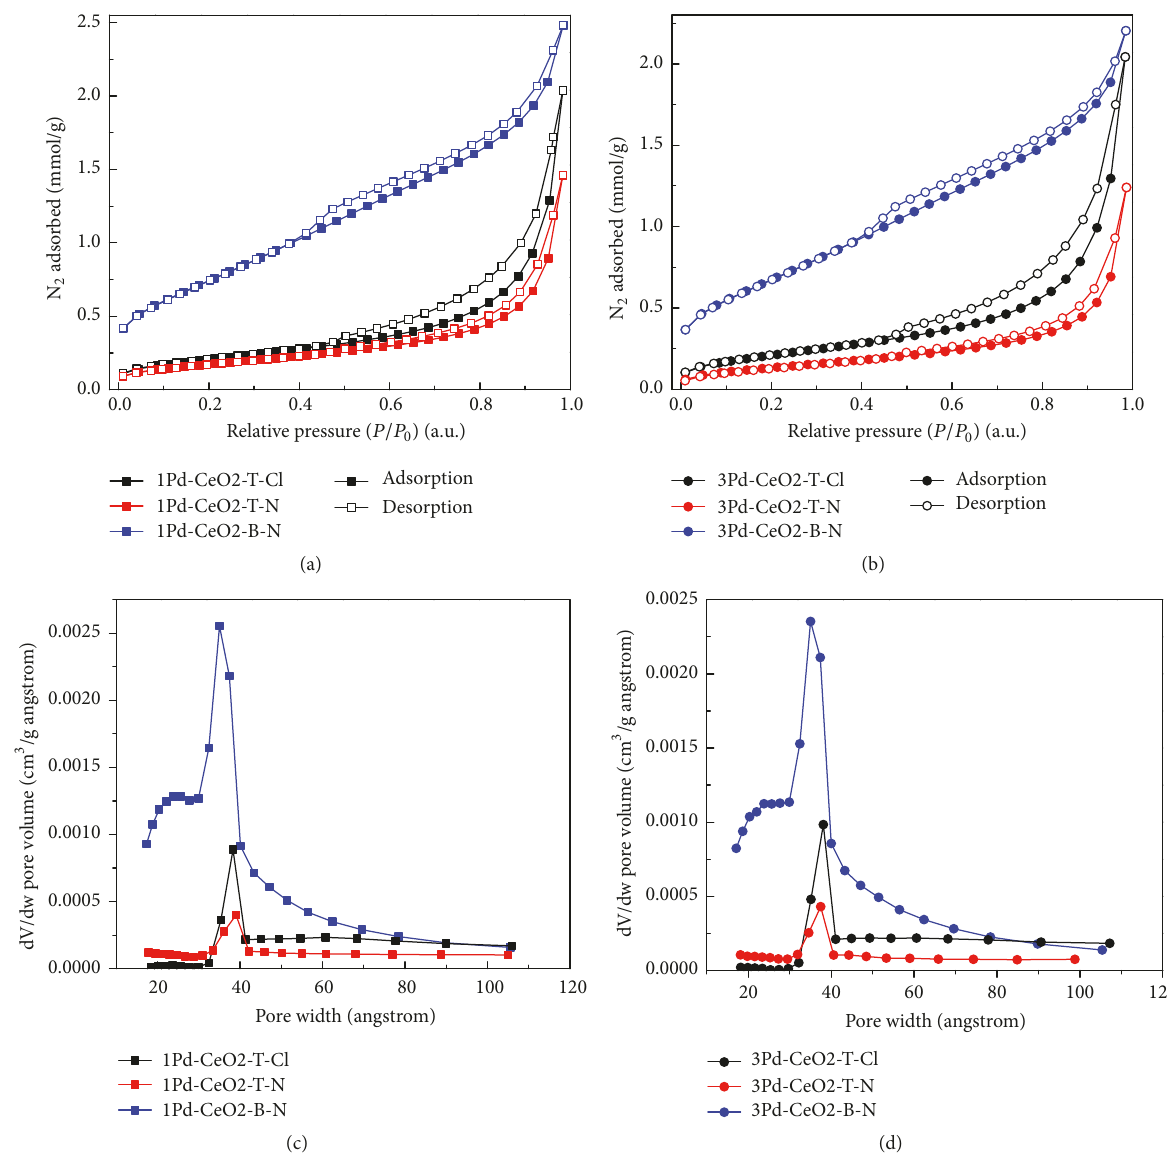
Figure 7: Nitrogen adsorption isotherms at 77 K of the (a) 1% and (b) 3% Pd-impregnated ceria catalysts; ((c) and (d)) their corresponding pore size distribution based on BJH method of the 1% and 3% Pd-impregnated ceria catalysts,